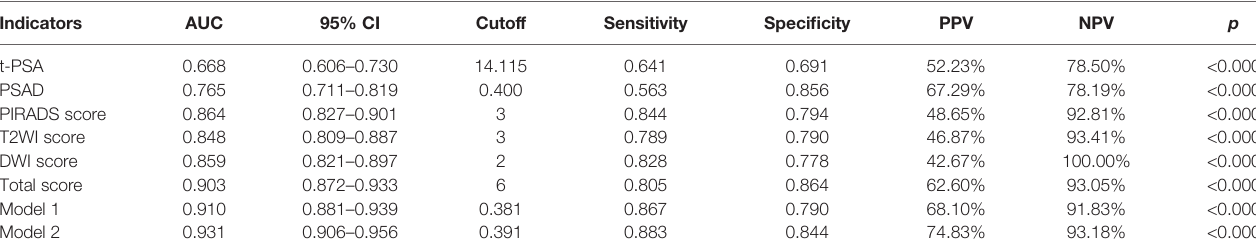
tPSA,totalPSA;PSAD,PSAdensity;PI-RADS score,prostateimagingreportinganddatesystemscore;T2WIscore,T2WI scorereferringtoPI-RADSv2;DWIscore,DWIscorereferring toPI-RADSscore;csPCa,clinicalsigni fi cantprostatecancer;Totalscore,T2WIscore+DWIscore.Model1=f/tPSA+PSAD+T2WIscore.Model2=f/tPSA+PSAD+Totalscore;AUC, area under the curve; 95% CI, 95% con fi dence interval for AUC; Cutoff, best cutoff; PPV, positive predictive value; NPV, negative predictive